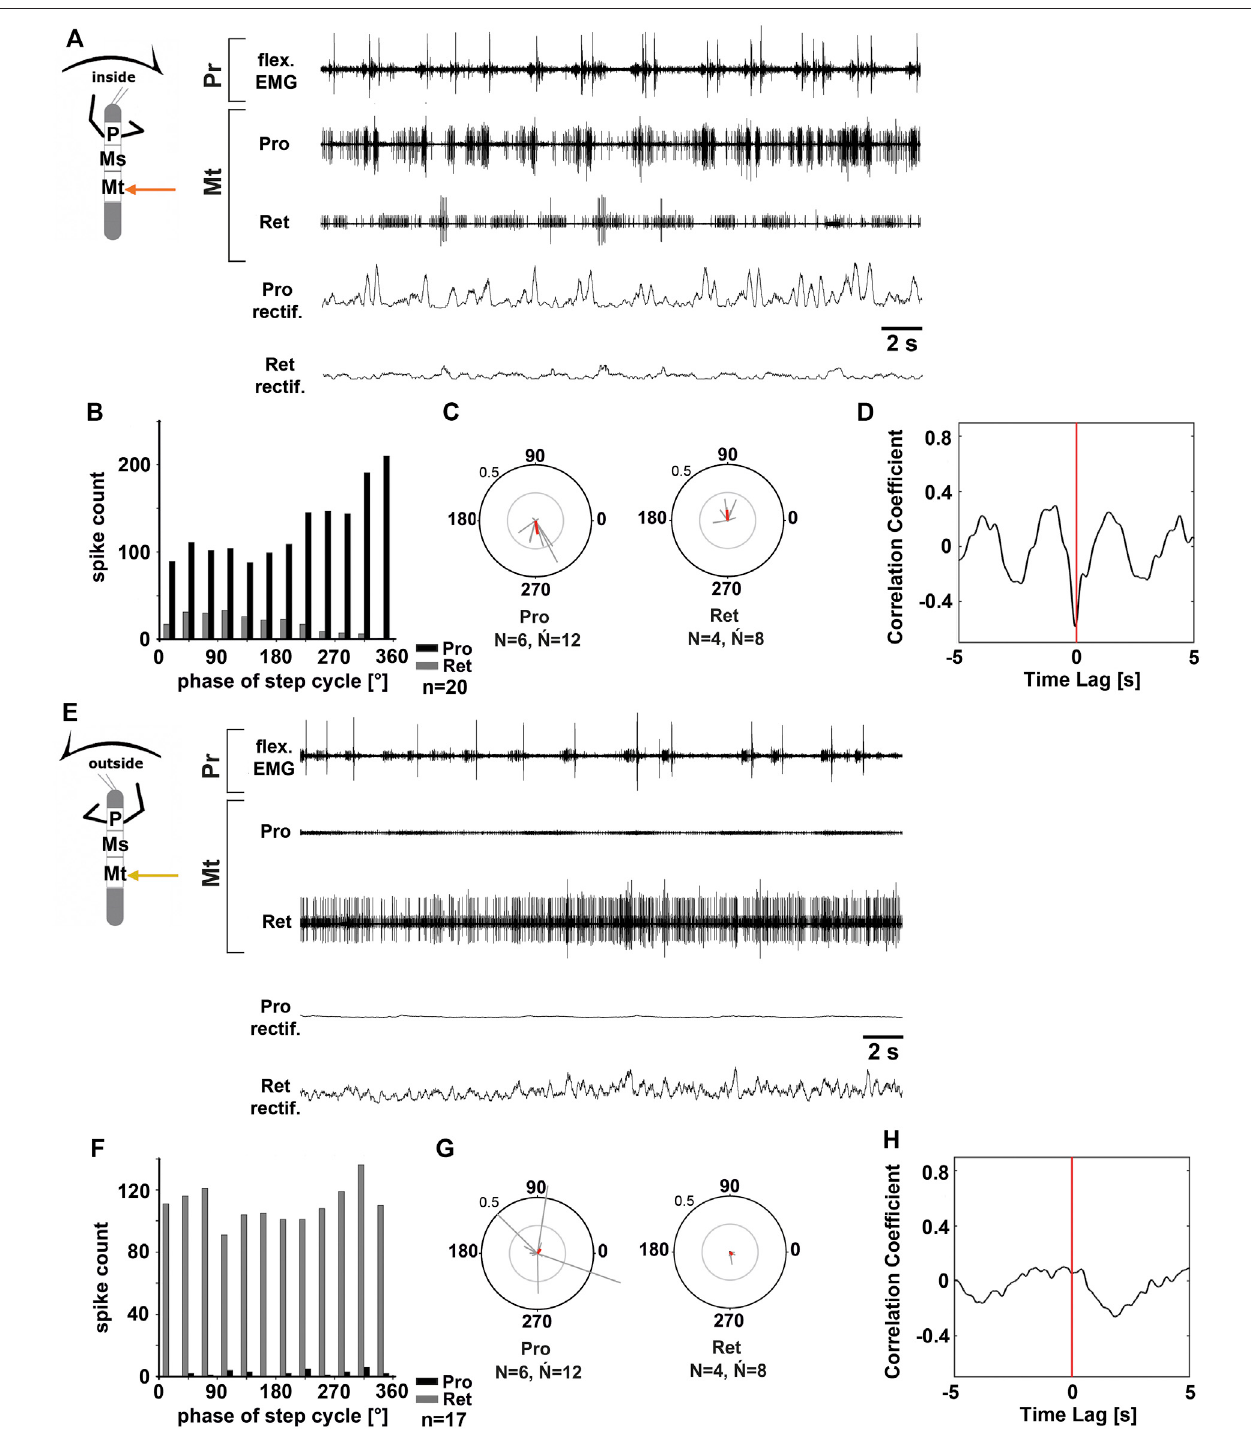
FIGURE 2 | Motor output of the metathoracic protractor and retractor coxae MN pools in the deafferented ganglion during front leg (FL) inside (A – D) and outside (F,H) stepping of the same animal. (A) FL fl exor EMG recording (top), together with extracellular recordings of the ipsilateral protractor (nl2 nerve, second trace) and retractor (nl5 nerve, third trace) nerve during an inside stepping sequence, as well as the recti fi ed protractor and retractor activities (fourth and fi fth trace); (B) Phase histogram of protractor and retractor nerve activity from the experiment in (A) with respect to the FL step cycle; (C) Polar plots with the spike event maxima (grey vectors)andtheirmean(red)forthemetathoracicprotractor(left)andretractor(right)withrespecttotheFLstepcycle; (D) cross-correlationanalysisoftheprotractorand retractor activity. (E) FL fl exor EMG (top), together with extracellular recordings of the ipsilateral protractor (second trace) and retractor (third trace) nerve during an